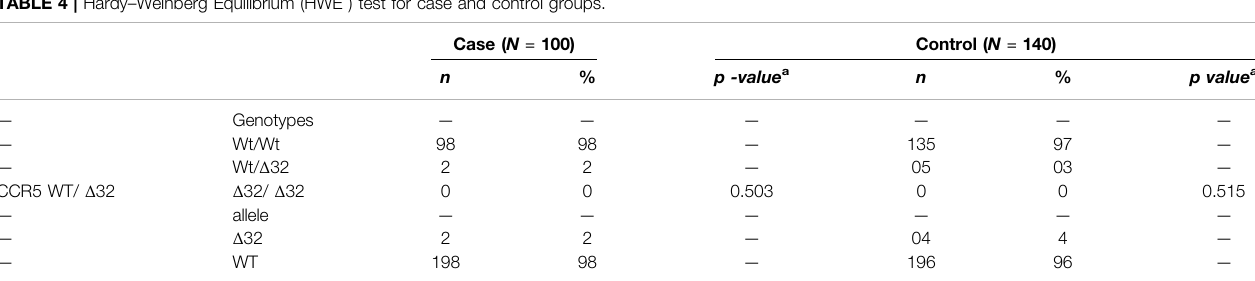
TABLE 4 | Hardy – Weinberg Equilibrium (HWE ) test for case and control